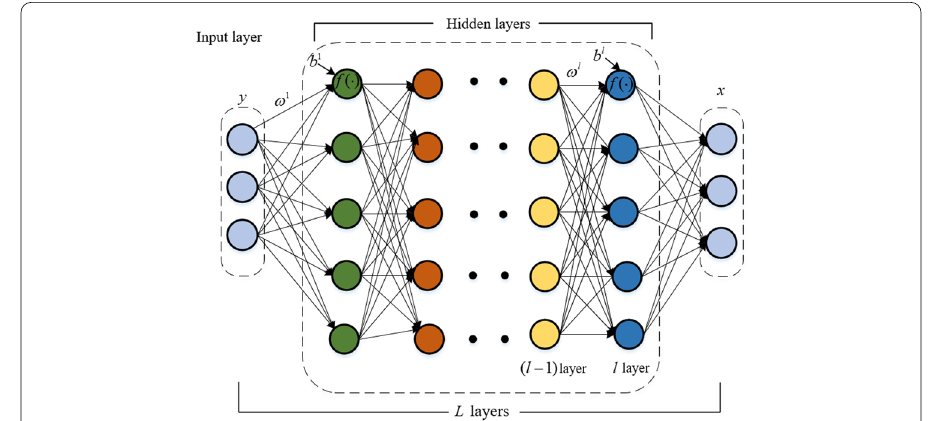
Fig. 1 The structure of deep neural